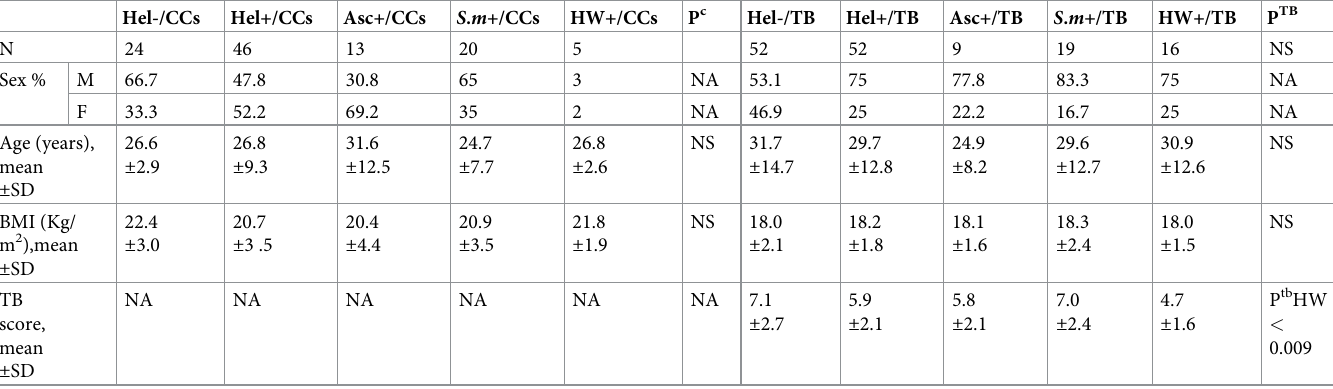
Table 1. Demographic characteristics and TB score values of CCs and TB patients.